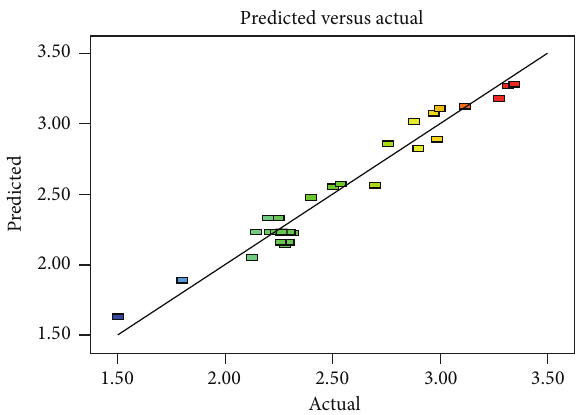
Figure 8: The correlation between the experimentally obtained values of the EY versus the calculated values using the model equation.